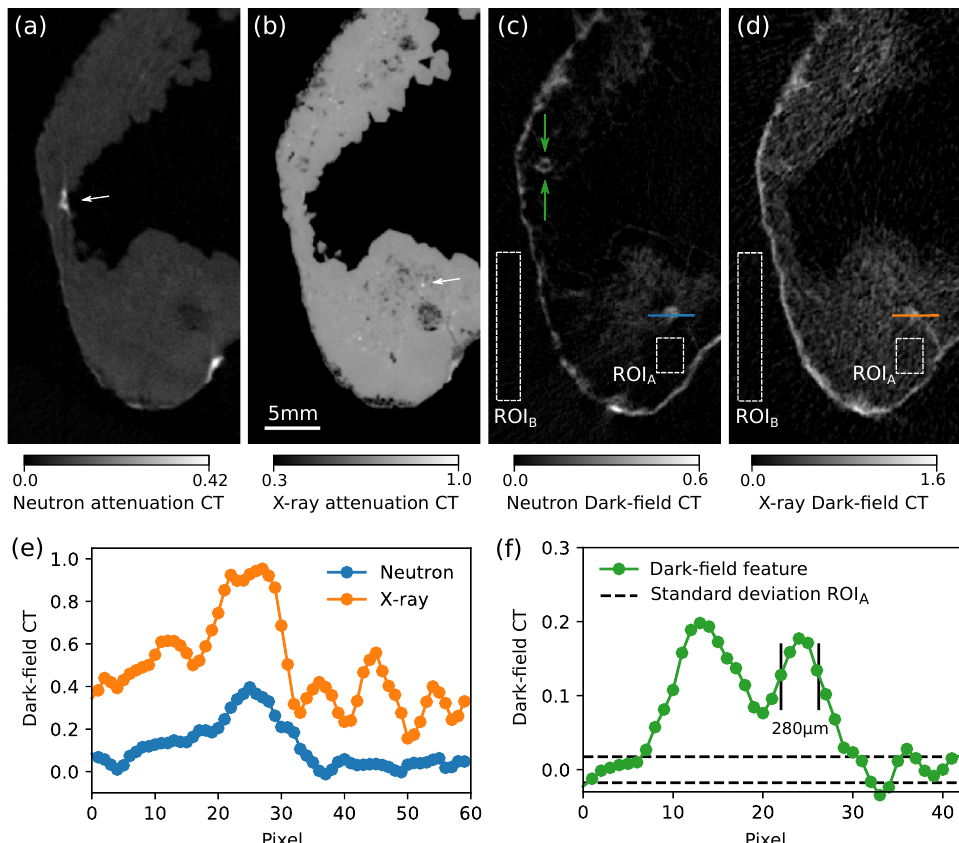
Figure 5. Slices in the xy-plane from the neutron attenuation volume ( a ), X-ray micro-CT ( b ), neutron DFI ( c ) and X-ray DFI ( d ). A line plot (see lines in ( c , d )) through a scattering feature which is used for CNR calculation is shown in ( e ). Another line plot ( f ) of the structure marked by green arrows in ( c ) plotted compared to the noise level (upper and lower boundaries of the standard deviation of ROI A